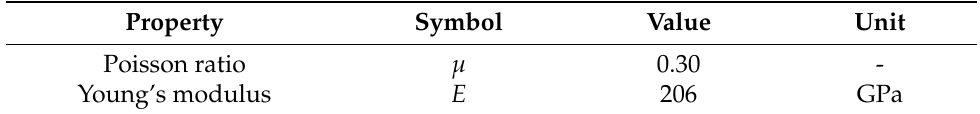
Table 3. Material constants of S235 steel.